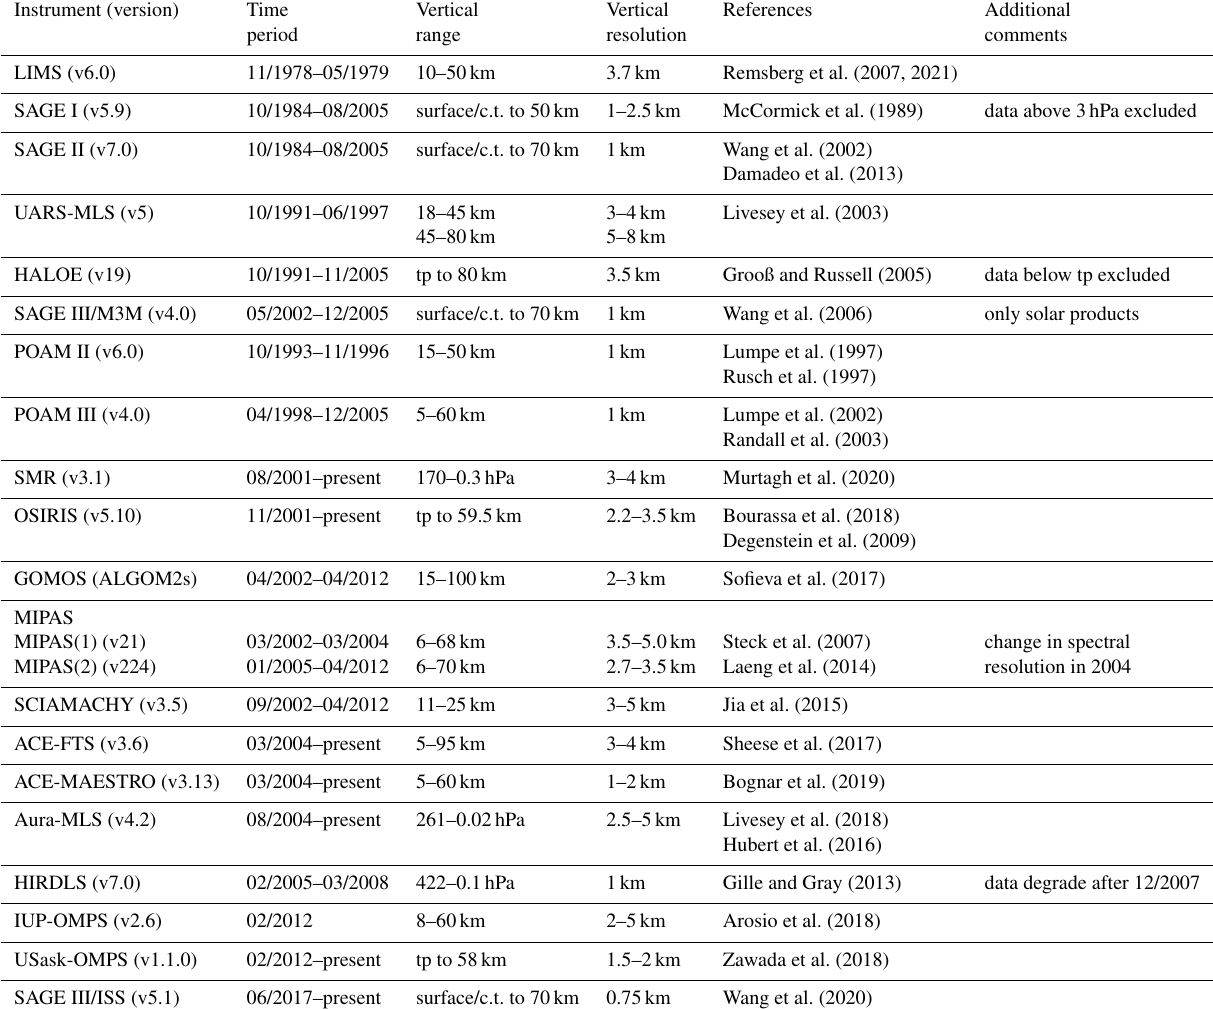
Table 9. Time period, vertical range, vertical resolution, references, and other comments for O 3 measurements. Note that tp refers to tropopause and c.t. to cloud top in this